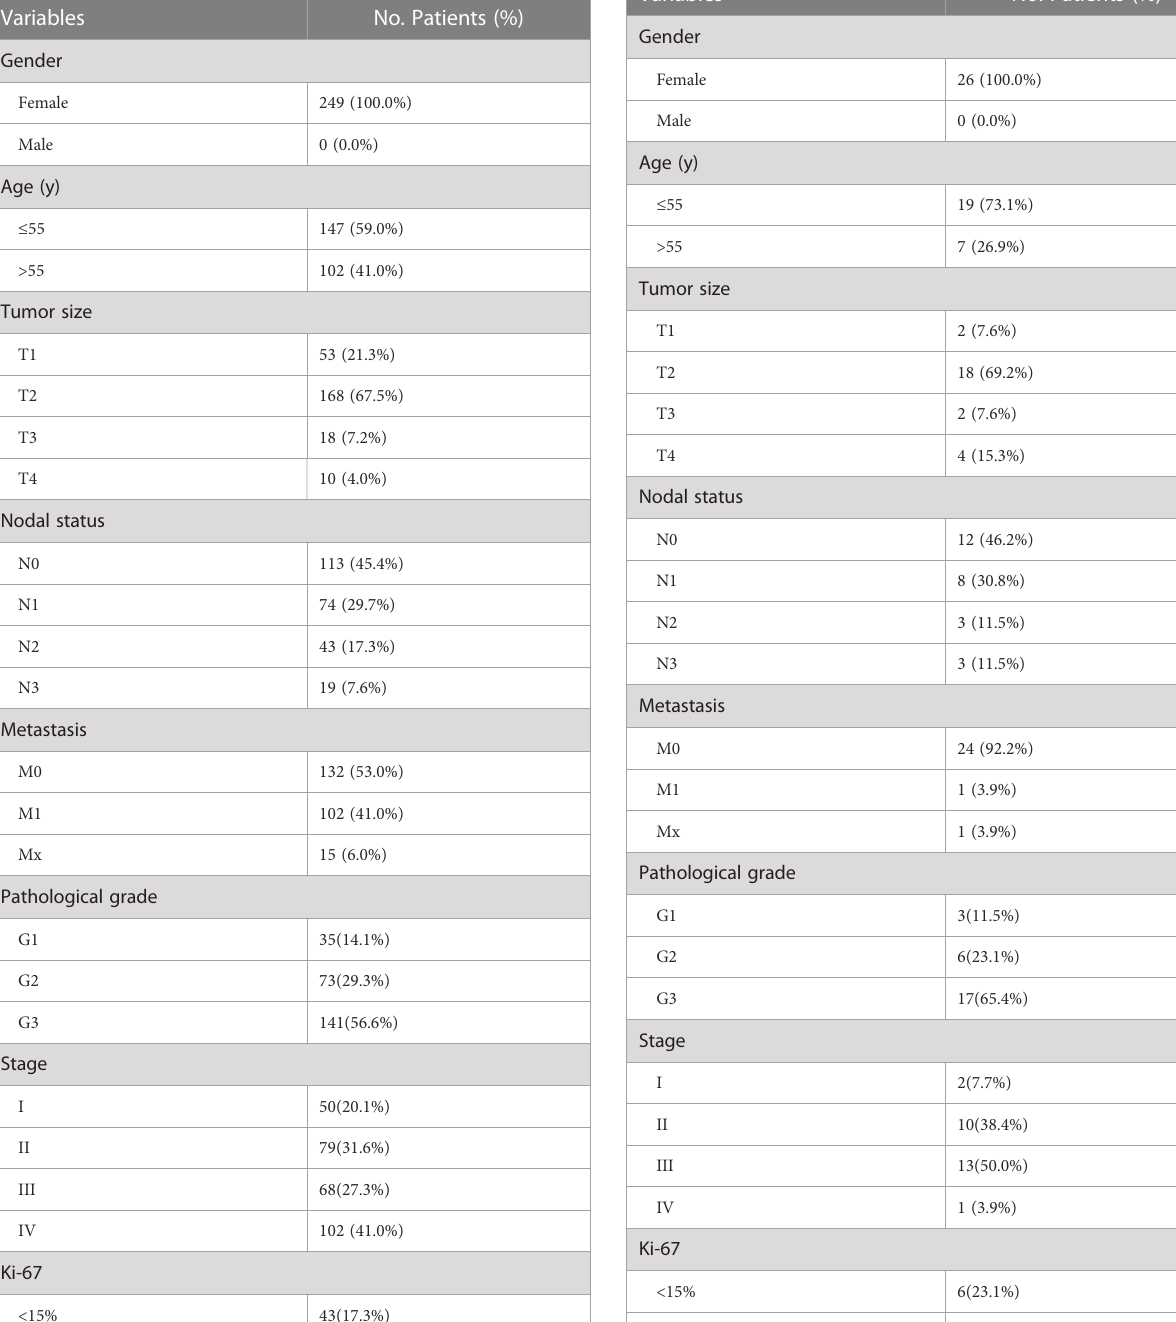
TABLE 2 Patient characteristics in further validation (n = 26